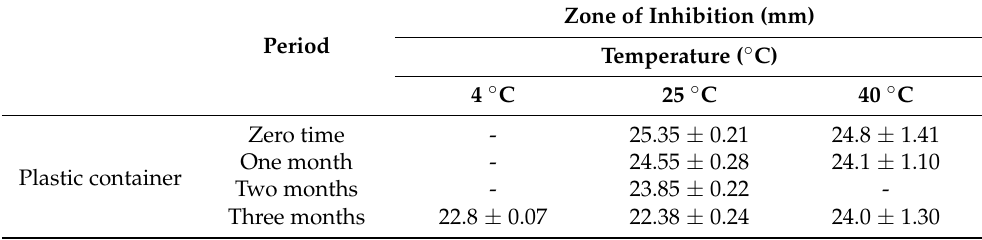
Table 8. Antibacterial activity of the F2 formulation over a three-month period at 4 ◦ C, 25 ◦ C, and 40 ◦ C ( n =